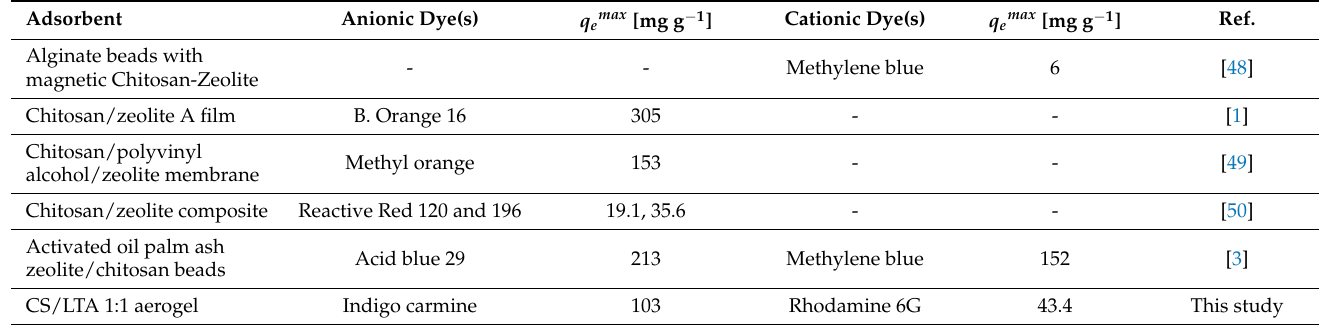
Table 3. Comparison of the dye adsorption capacity of CS/LTA aerogels with data reported in the literature.